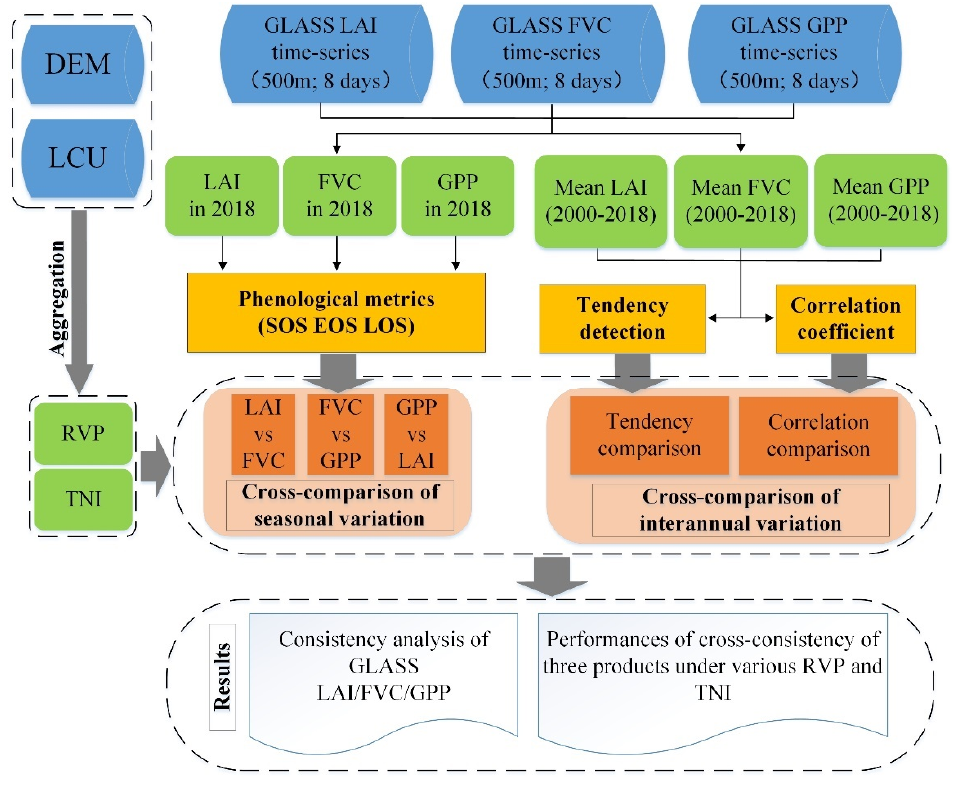
Figure 1. Flowchart of the comparison scheme for GLASS LAI/FVC/GPP from 2000 to 2018 in the TRSR. All abbreviations are mentioned in the text for the first time.